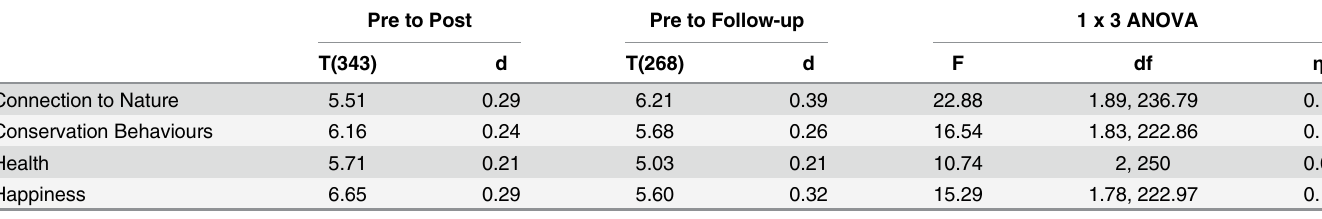
Table 3. Summary of paired t-tests and repeated measures ANOVA